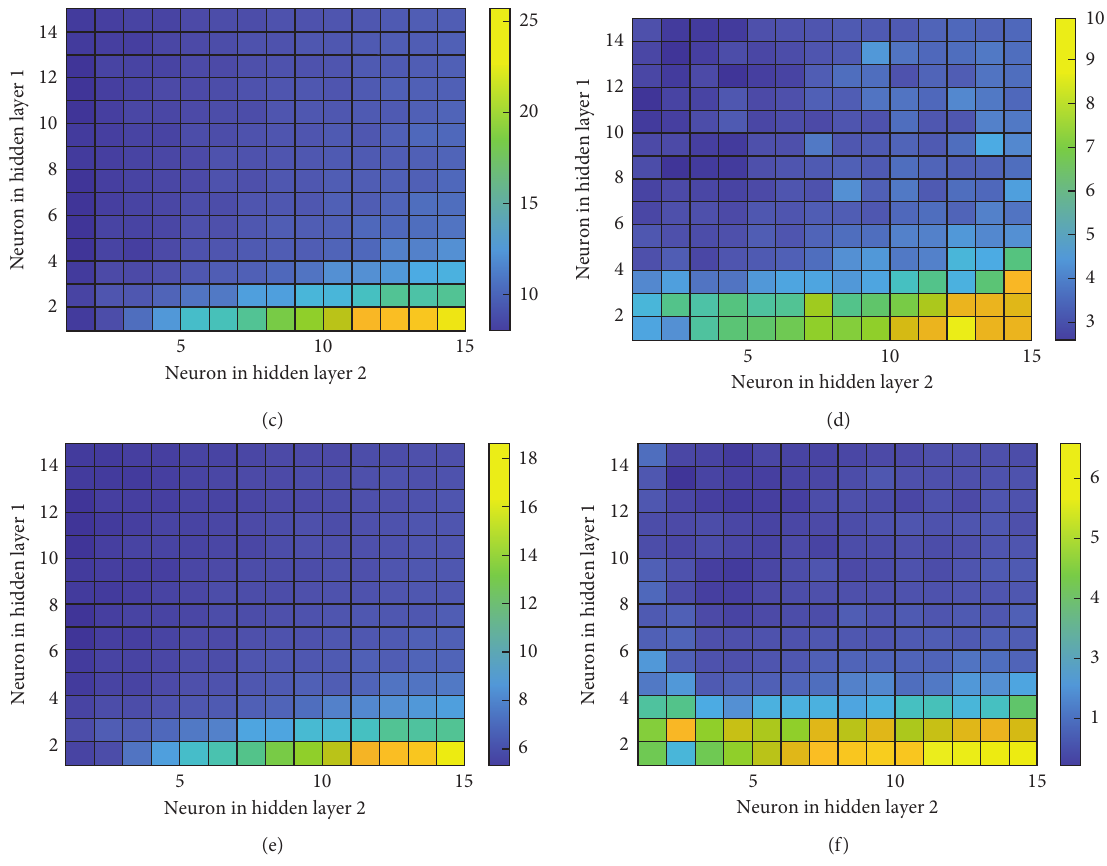
Figure 7: Color-map of ANN with 2 hidden layers in the function of neuron number of the hidden layer for the testing part with respect to (a) mean values of R 2 ; (b) StD of R 2 ; (c) mean of RMSE; (d) StD of RMSE; (e) mean of MAE; and (f) StD of